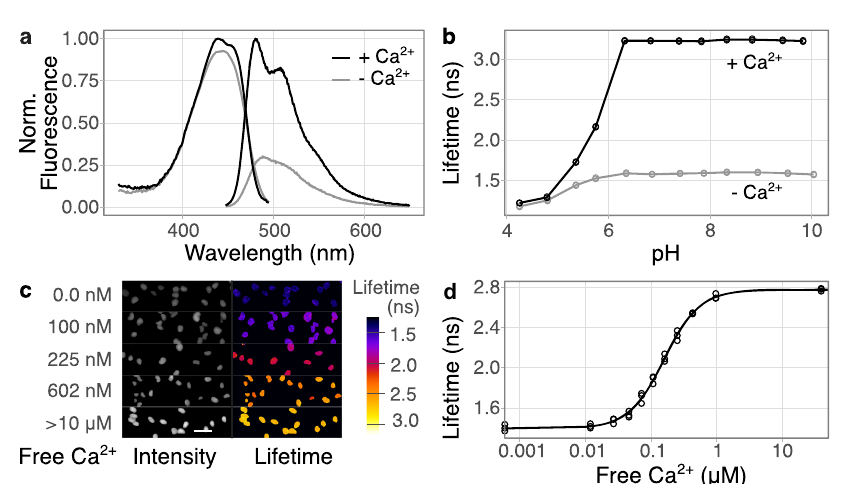
Fig. 3 Main characteristics of Tq-Ca-FLITS. a Normalized absorbance and emission spectra of Tq-Ca-FLITS in vitro for the calcium-bound and -unbound state. b Tq-Ca-FLITS is pH insensitive from pH 6.2 onwards, as shown by the phase lifetime of the calcium-bound and -unbound states in vitro ( n = 3 with line average). c The phase lifetime of Tq-Ca-FLITS stabilizes in HeLa cells during the in situ calibration. The endpoint of fi ve concentrations is shown. Visual display is generated by an ImageJ macro 52 . Scale bar is 50 μ m. d Calibration curve of the phase lifetime in situ, with the calcium concentration on a logarithmic scale ( n = 3). Source data are provided as a Source Data fi